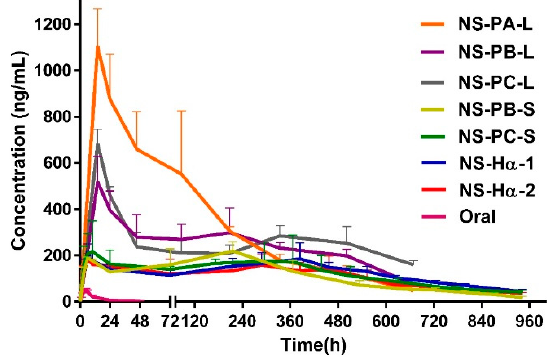
Figure 4. Average plasma concentration-time curve.